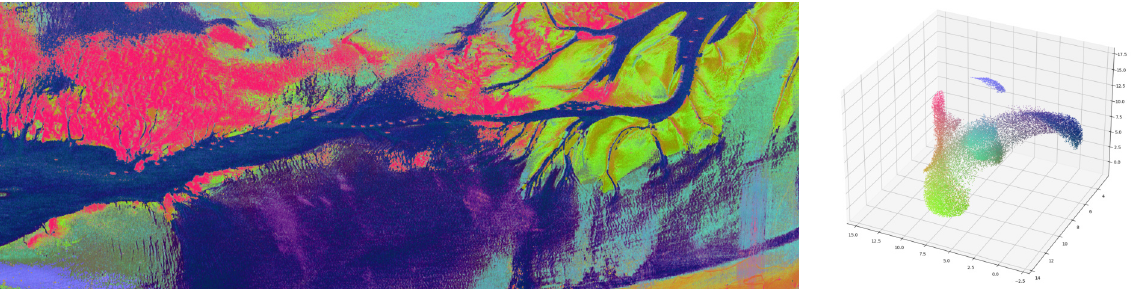
Figure 7. Pseudo color image of tidal area, covering 6,3 km 2 , and the corresponding 3D scatter